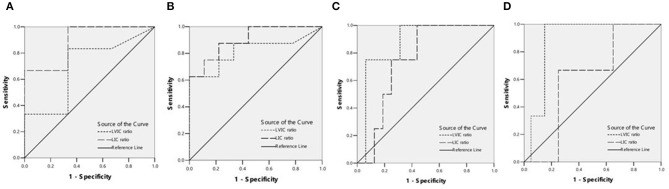
(A) ROC curves showed the comparison of liver VIC (LVIC) and LIC in differentiating patients with ASF < 500 ng/ml or 500 = ASF < 1,000 ng/ml (9 patients). LIC Az was 0.889, and LIC at 1.8 (mg Fe/g) sensitivity and specificity were 100 and 33.3%, respectively. LVIC Az was 0.694, and LVIC at 1.34 (mg/ml) sensitivity and specificity were 33.3 and 66.7%, respectively. There was significant difference between LVIC and LIC sequences (p < 0.05). (B) ROC curves showed the comparison of LVIC and LIC in differentiating patients with ASF < 1,000 ng/ml or 1,000 = ASF < 2,500 ng/ml (17 patients). LIC Az was 0.903, and LIC at 3.2 (mg Fe/g) sensitivity and specificity were 100 and 33.3%, respectively. LVIC Az was 0.819, and LVIC at 1.85 (mg/ml) sensitivity and specificity were 62.5 and 88.9%, respectively. There was no significant difference between LVIC and LIC sequences (p > 0.05). (C) ROC curves showed the comparison of LVIC and LIC in differentiating patients with ASF < 2,500 ng/ml or 2,500 = ASF < 5,000 ng/ml (20 patients). LIC Az was 0.750, and LIC at 7.0 (mg Fe/g) sensitivity and specificity were 75 and 56.2%, respectively. LVIC Az was 0.875, and LVIC at 2.69 (mg/ml) sensitivity and specificity were 75 and 81.2%, respectively. There was no significant difference between LVIC and LIC sequences (p > 0.05). (D) ROC curves showed the comparison of LVIC and LIC in differentiating patients with ASF < 5,000 ng/ml or 5,000 = ASF ng/ml (23 patients). LIC Az was 0.617, and LIC at 15.0 (mg Fe/g) sensitivity and specificity were 100 and 30%, respectively. LVIC Az was 0.883, and LVIC at 4.03 (mg/ml) sensitivity and specificity were 100 and 85%, respectively. There was significant difference between LVIC and LIC sequences (p < 0.05).